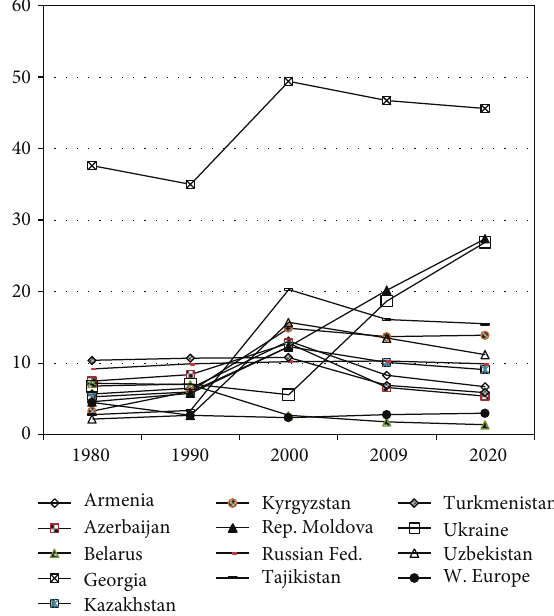
F 5: Labour force participation of persons at 65 years and over,